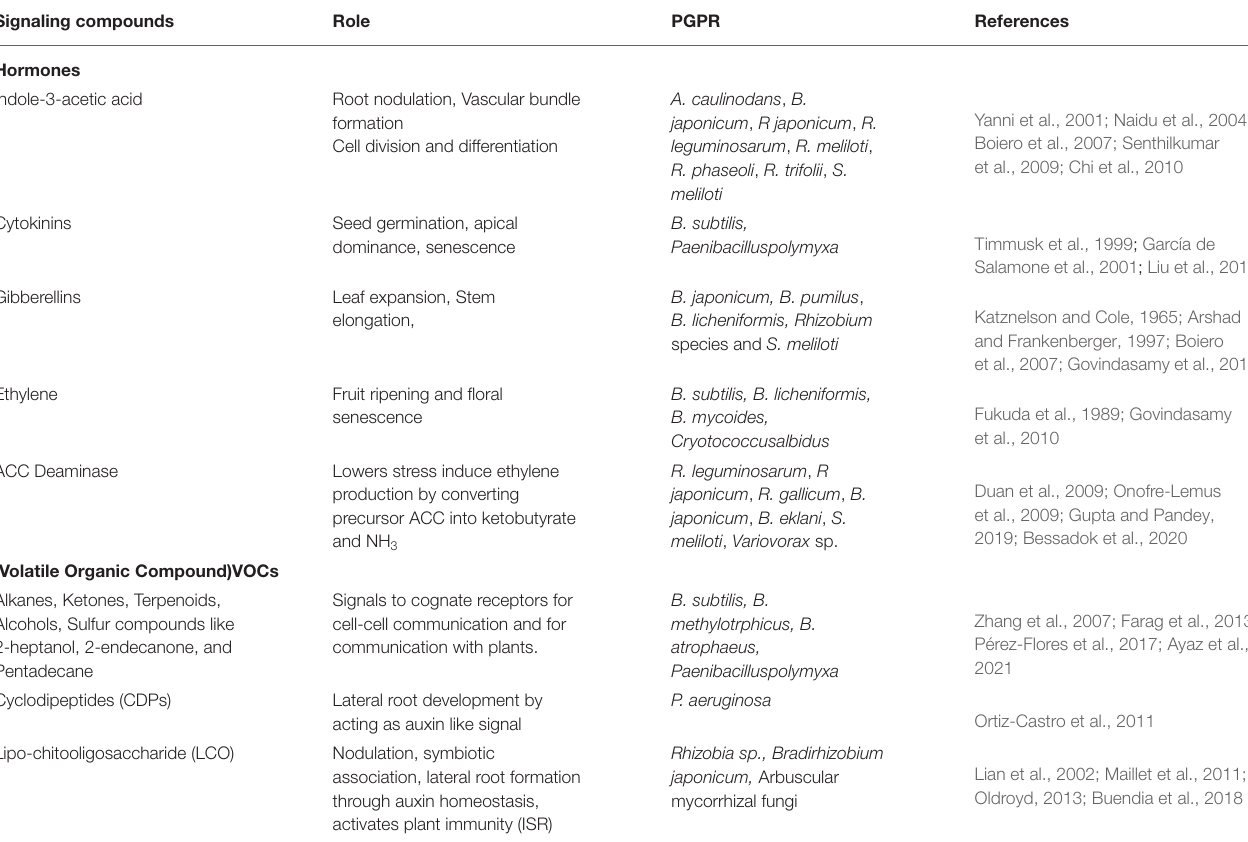
TABLE 1 | Signaling compounds produced by